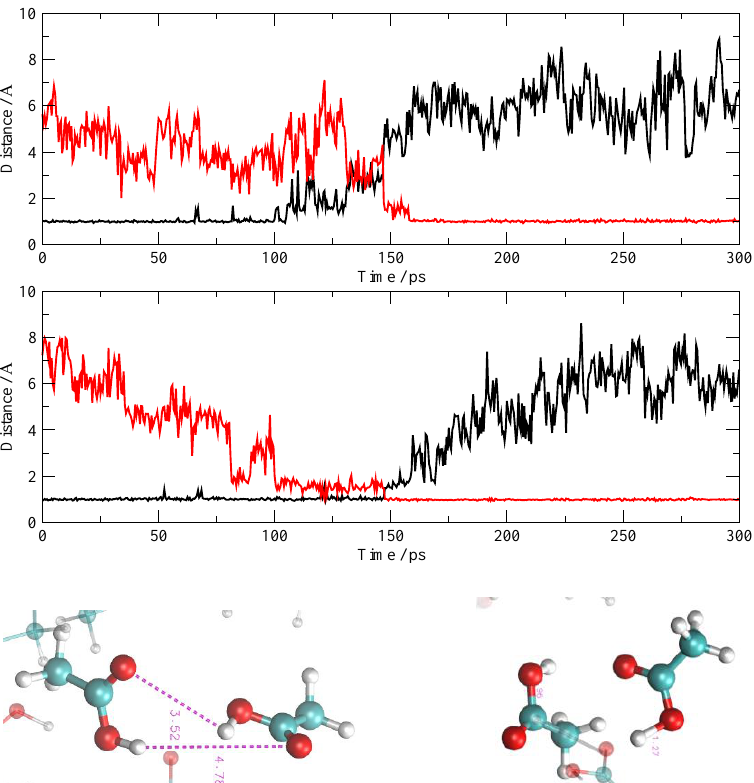
Figure 7. One of the double AcOH → AcOH proton transfers. The two plots report the four O–H distances involved, in red and black for acceptors and donors, respectively. The two snapshots below show the geometric configurations of the involved molecules before and after the transfer.